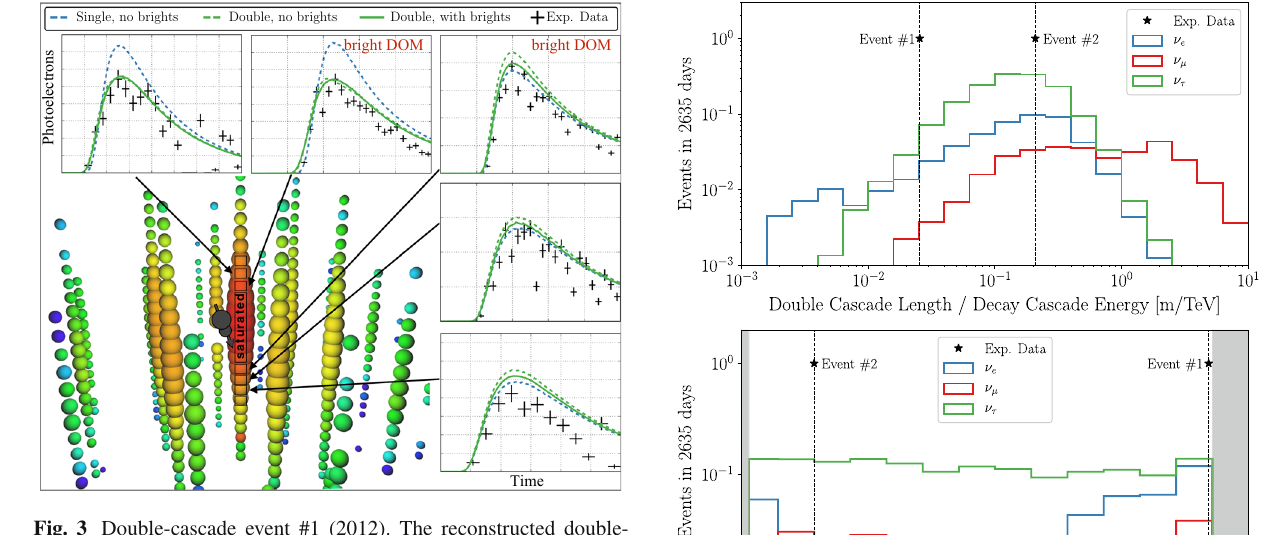
Fig. 3 Double-cascade event #1 (2012). The reconstructed double- cascade vertex positions are indicated as grey circles, the direction indi- cated with a grey arrow. The size of the circles illustrates the relative deposited energy, the color encodes relative time (from red to blue). Bright and saturated DOMs are excluded from this analysis